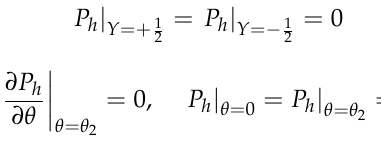
Figure 9. Diagram of journal bearing.